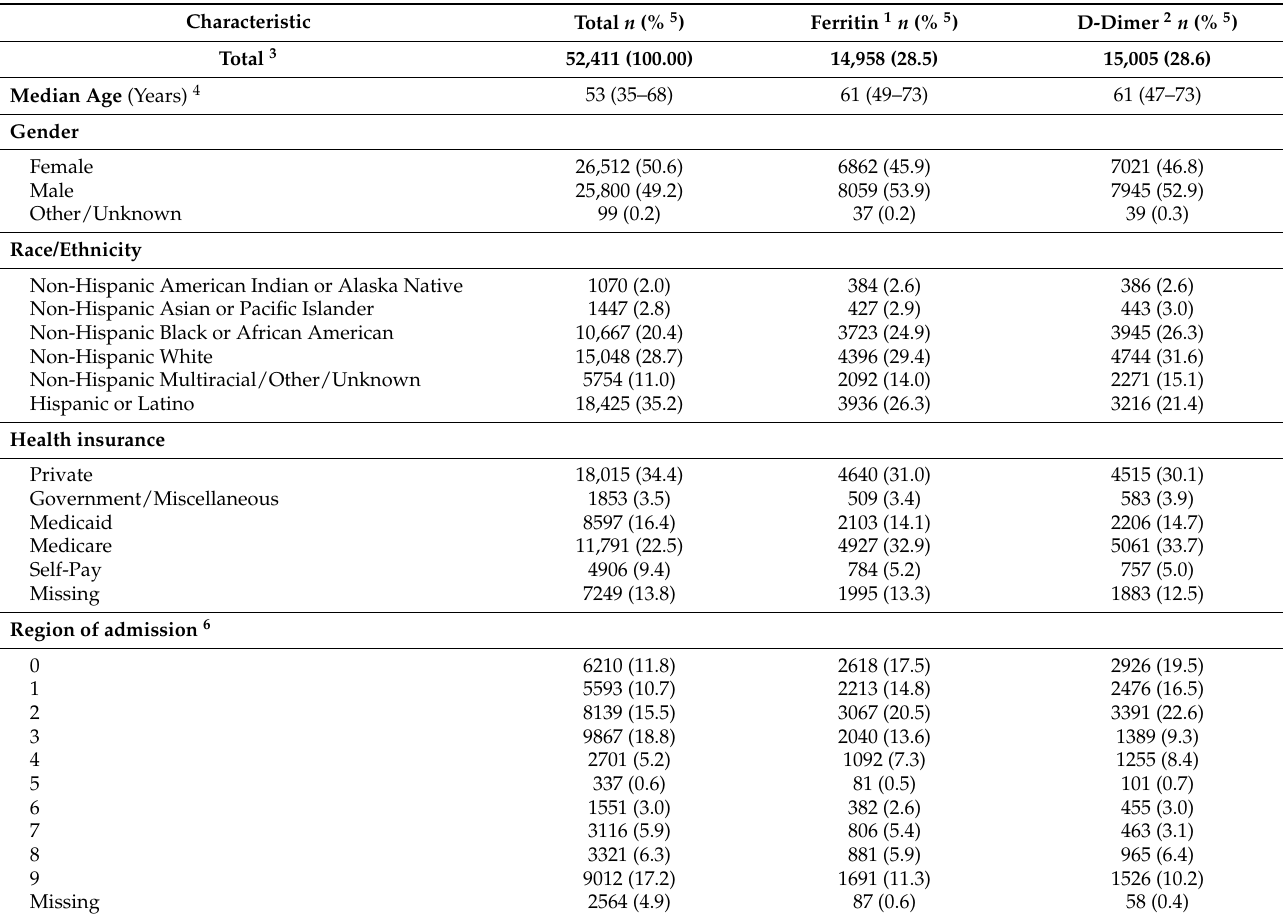
Table 2. Demographic characteristics among COVID-19 patients with valid ferritin and D-dimer laboratory